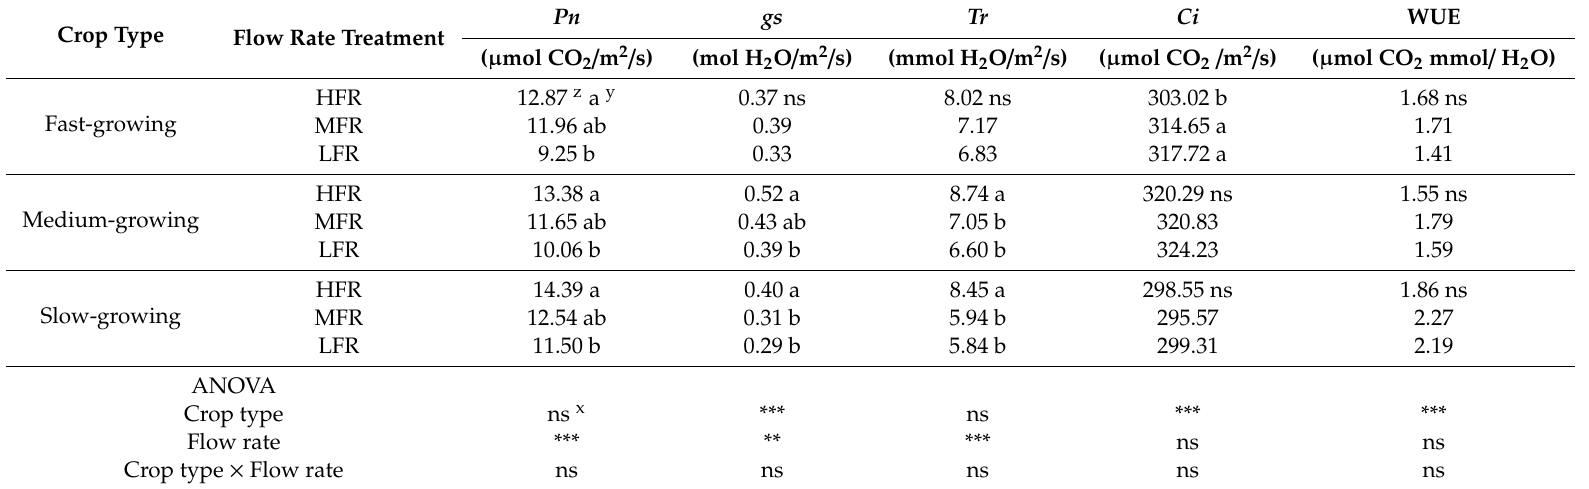
Table 8. Plant photosynthetic rate ( Pn ), stomatal conductance ( gs ), transpiration rate ( Tr ), intercellular CO 2 concentration ( Ci ), and intrinsic water use e ffi ciency (WUE) of crops grown in aquaponics with high (HFR, 3.3 m / day), medium (MFR, 2.2 m / day), and low (LFR, 1.1 m / day) flow rate. The values are photosynthetic parameters measured at day 21 after